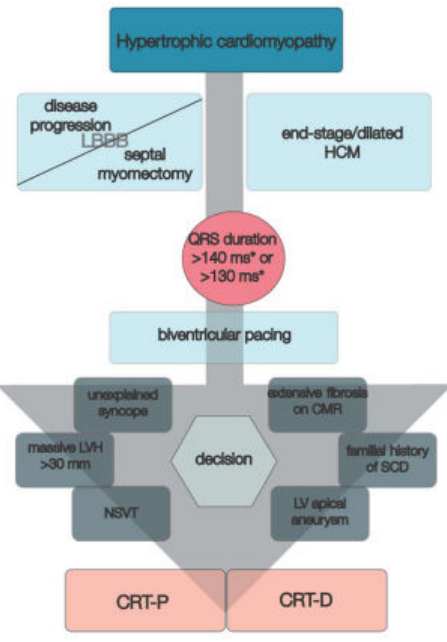
Figure 6. CRT in primary prevention of SCD in patients with hypertrophic cardiomyopathy. * > 140 ms in men and >130 ms in women. Abbreviations: CMR, cardiac magnetic resonance imag- ing; CRT-D, cardiac resynchronization therapy with defibrillator; CRT-P, cardiac resynchronization therapy with pacemaker; HCM, hypertrophic cardiomyopathy; LV, left ventricle; LVH, left ventricle hypertrophy; NSVT, non-sustained ventricular tachycardia; SCD, sudden cardiac